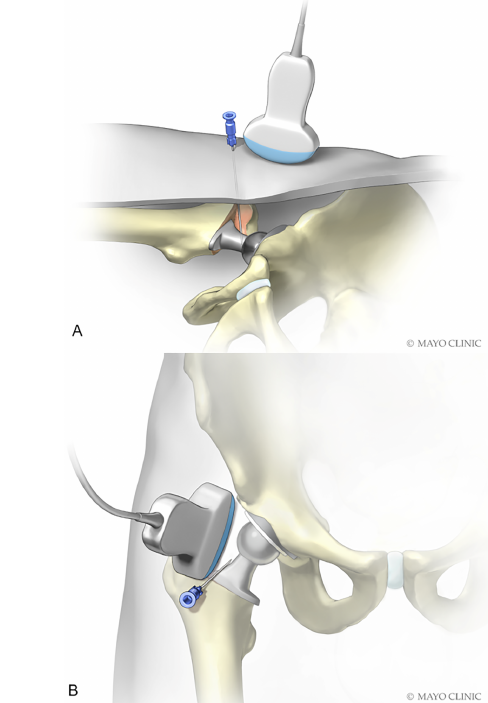
Figure 5. Depiction of needle placement lateral and slightly deep to neck of prosthesis. (Used with permission of Mayo Foundation for Medical Education and Research. All rights